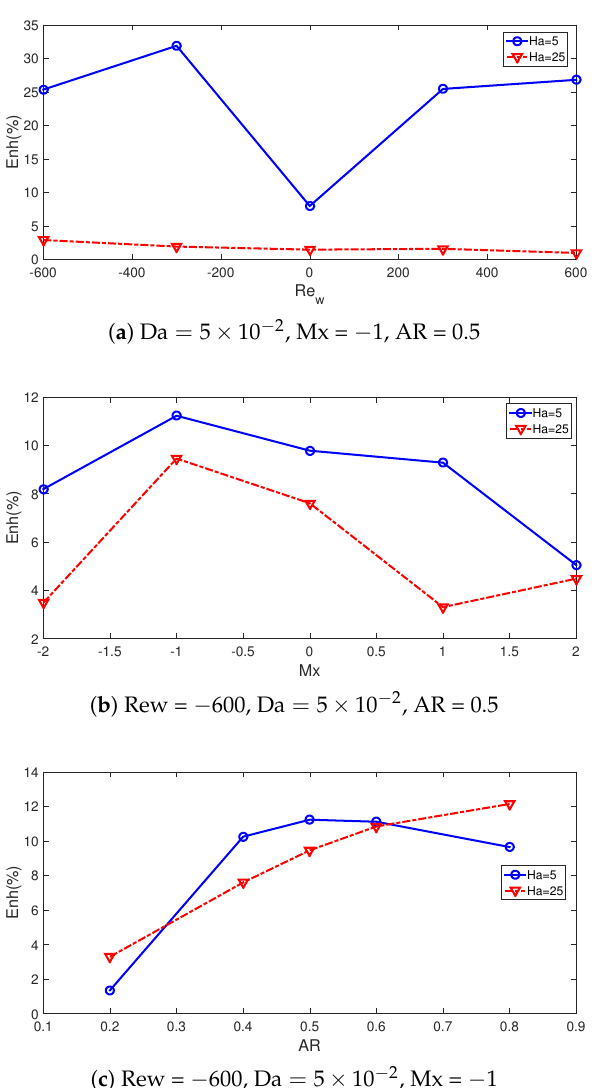
Figure 17. Effects of ( a ) Rew, ( b ) location, and ( c ) aspect ratio of the porous object on the enhancements in the average Nu as compared to optimized flow configurations at two different MaF strength